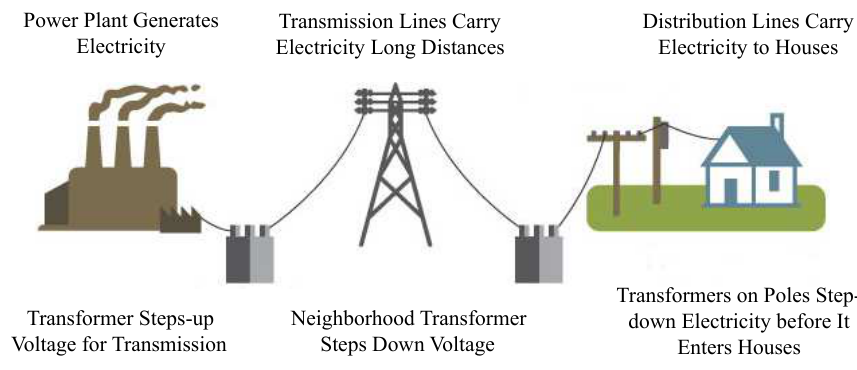
Figure 3. Electricity generation, transmission and distribution.